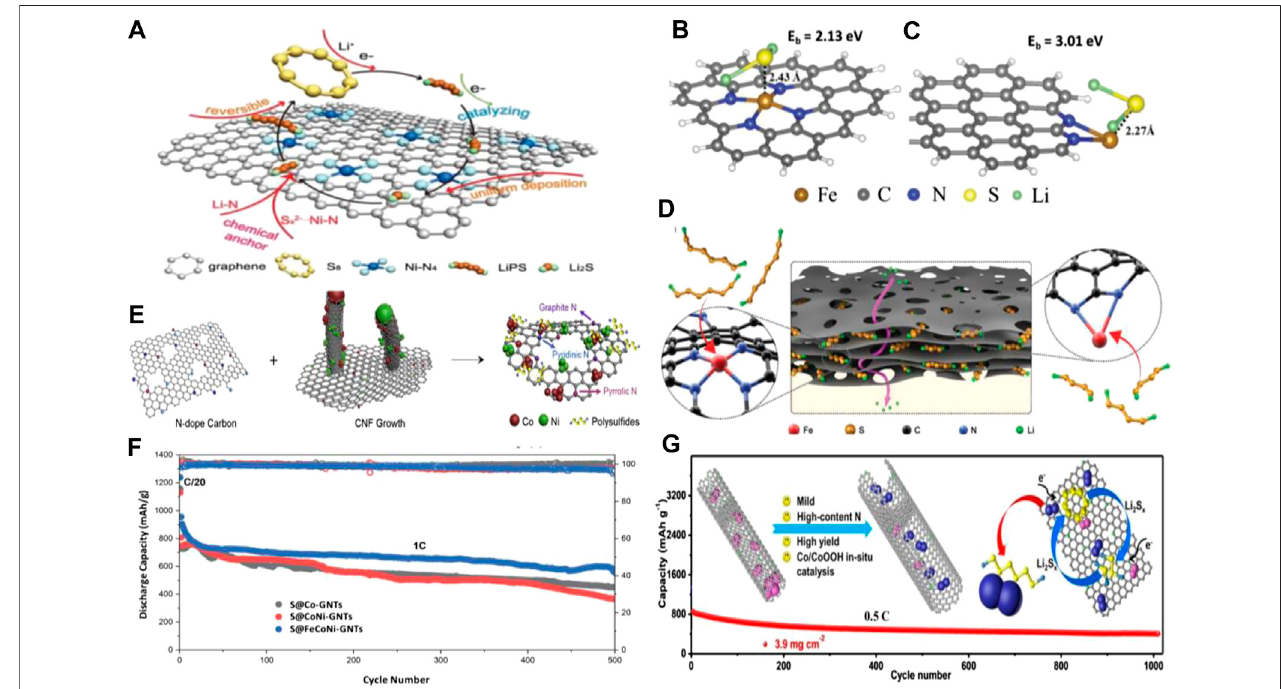
FIGURE3|(A) ThecatalyticandchemicallytrappingmechanismoftheLiPSonthesurfaceofNi@NGintheelectrochemicalprocess.Reproducedwithpermission from Zhang et al. (2019e). Copyright © 2019 WILEY-VCH Verlag GmbH and Co. KGaA, Weinheim. Optimized con fi gurations for the binding of Li 2 S to (B) Fe – N 4 and (C) Fe – N 2 moieties on graphene (Li 2 S binding energies and selected bond distances are indicated in images) (D) Schematic illustration of the con fi nement of sulfur and polysul fi des in the layer structure and the additional ionic diffusion pathways (purple arrow line) through the holey structure (the black sheets). Reproduced with permission from Wang et al.(2019b). Copyright © 2018WILEY-VCH Verlag GmbH and Co.KGaA, Weinheim (E) Designing strategy of NiCo-CNF@CF interlayer for Li-S batteries. Reproduced with permission from Zhang et al. (2019a) Copyright © 2019 Elsevier Ltd (F) Capacity retention between S@Co-GNTs, S@CoNi-GNTs, and S@ FeCoNi-GNTs at 1 C . Reproduced with permission from Ogoke et al. (2019). Copyright © 2019 The Royal Society of Chemistry (G) The schematic of 1D high-content N-doped graphene nanoribbons@Co/CoOOH high-yield and in-situ fabricated as an integrated host for Li-S batteries and the long cycling performance. Reproduced with permission from Tan et al. (2020) Copyright © 2020 The Royal Society of Chemistry.